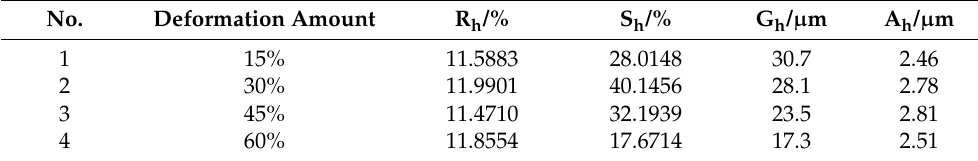
Table 2. The R h , S h , G h , A h of C250 after heat